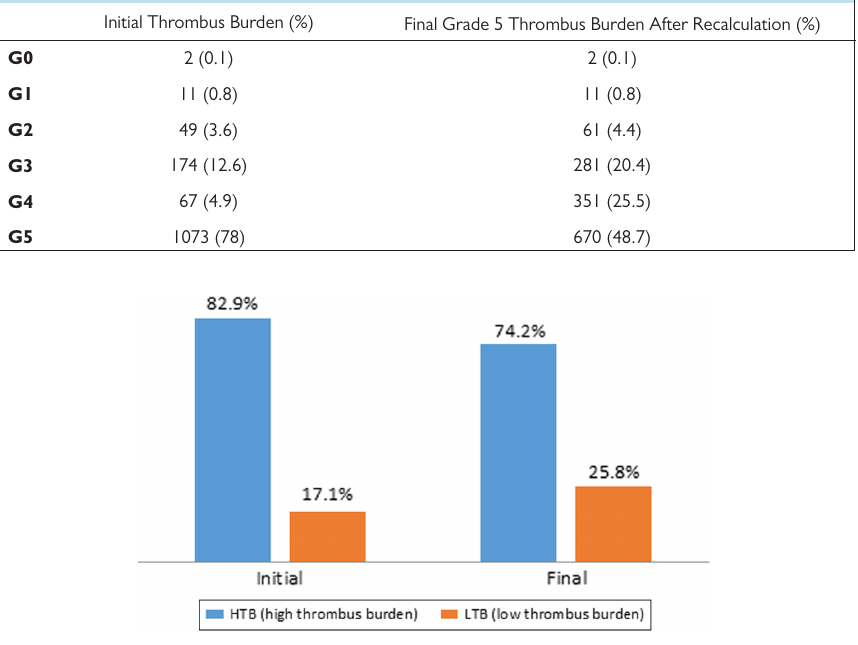
Figure 2. Initial and final thrombus burden.